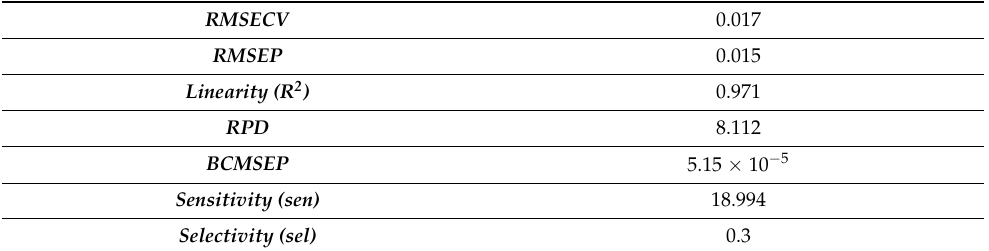
Table 3. Estimation of analytical performance parameters of the models using PLSR data (RMSECV, RMSEP, and BCMSEP are in mg resorcinol/mg SC, sensitivity is in (mg SC · mg of resorcinol − 1 ), and all other parameters are